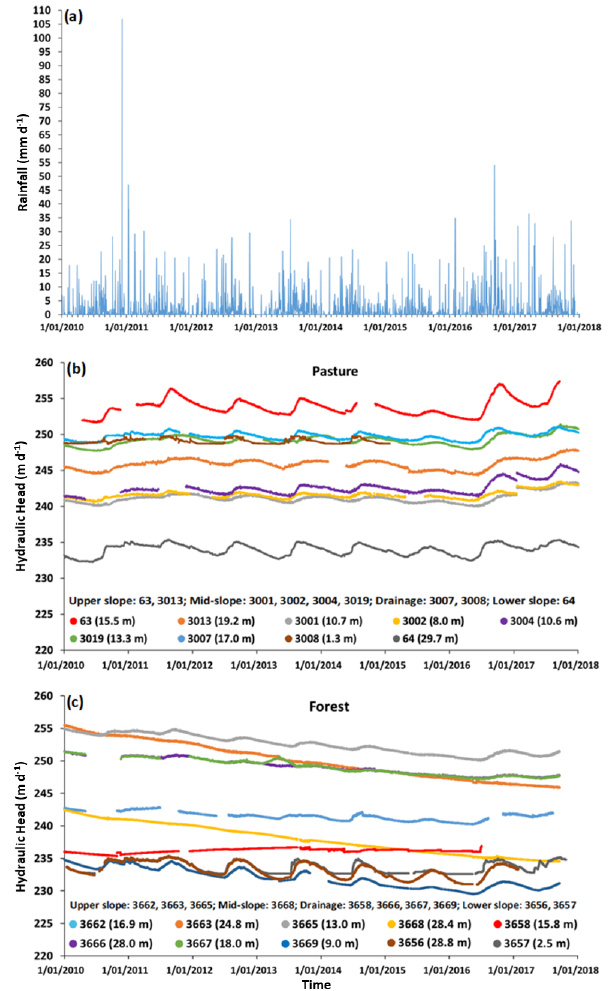
Figure 3. (a) Daily rainfall at Cavendish (station 089009, ∼ 19km southeast of Gatum). Variation in groundwater heads from bores in (b) pasture and (c) forest (Dresel et al., 2018). The legend shows the sample depths (in parentheses) and landscape